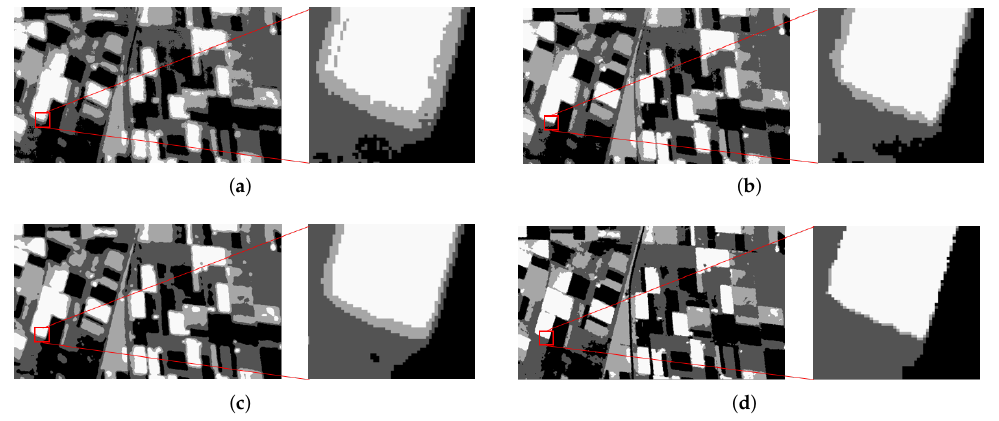
Figure 14. Local detail maps of segmentation results. ( a ) The result of NS_FCM. ( b ) The result of RFCM_BNL. ( c ) The result of LBNL_FCM. ( d ) The result of GLR_FCM.